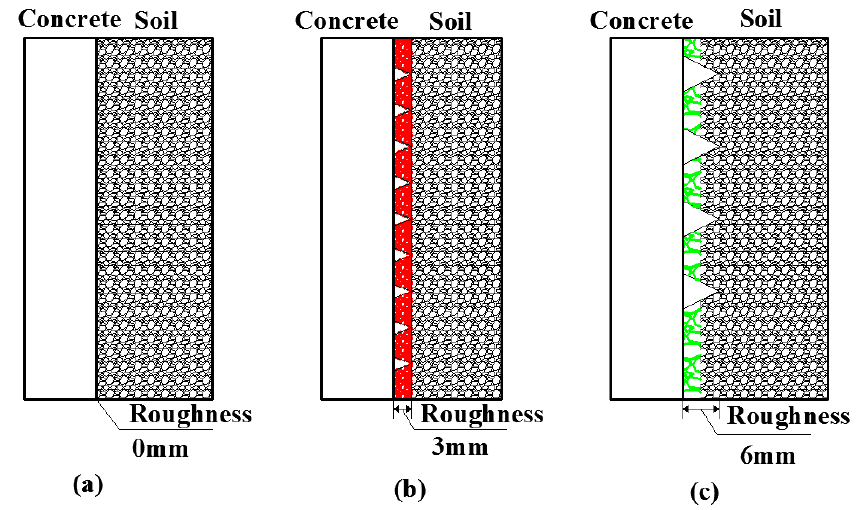
Figure 10. Schematic graph for different interface roughnesses. ( a ) Schematic graph for the interface roughness of 0 mm; ( b ) schematic graph for interface roughness of 3 mm; ( c ) schematic graph for interface roughness of 6 mm.